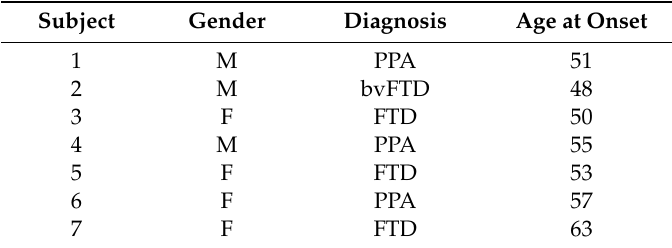
Table 1. Clinical and demographic characteristics of sporadic frontotemporal dementia (sFTD) patients included in the